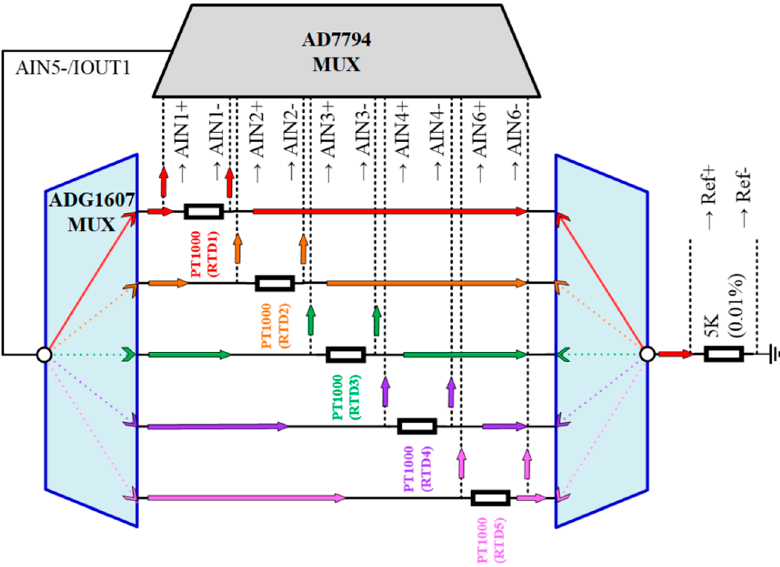
Figure 2. Schematic diagram of the current flow path for an analog input channel in parallel.